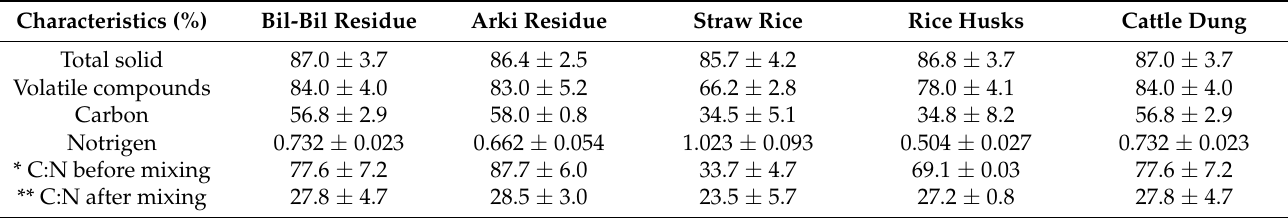
Table 2. Composition of lignocellulosic biomasses (Dry weight